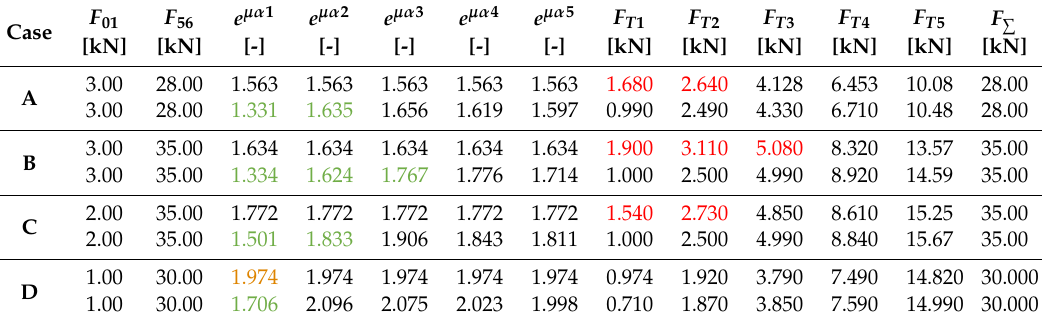
Table 3. A comparison of dynamic tension distribution versus uniform tension distribution